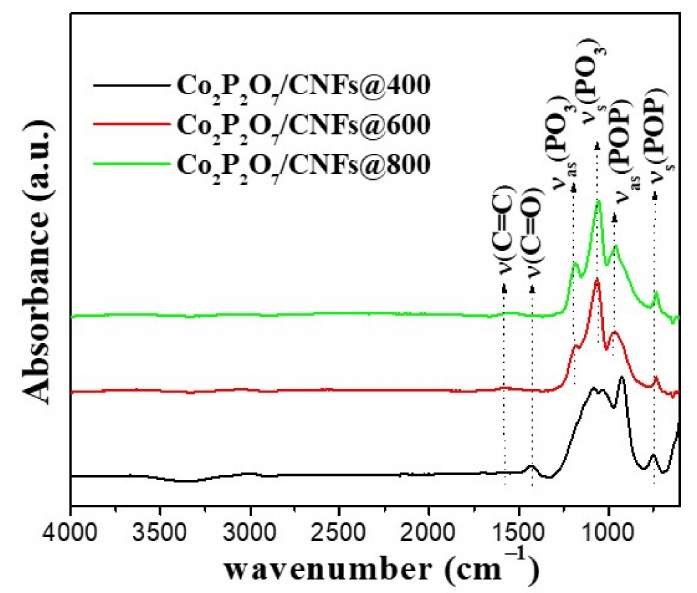
Figure 7. FT–IR spectra of Co 2 P 2 O 7 /CNFs@400, Co 2 P 2 O 7 /CNFs@600 and Co 2 P 2 O 7